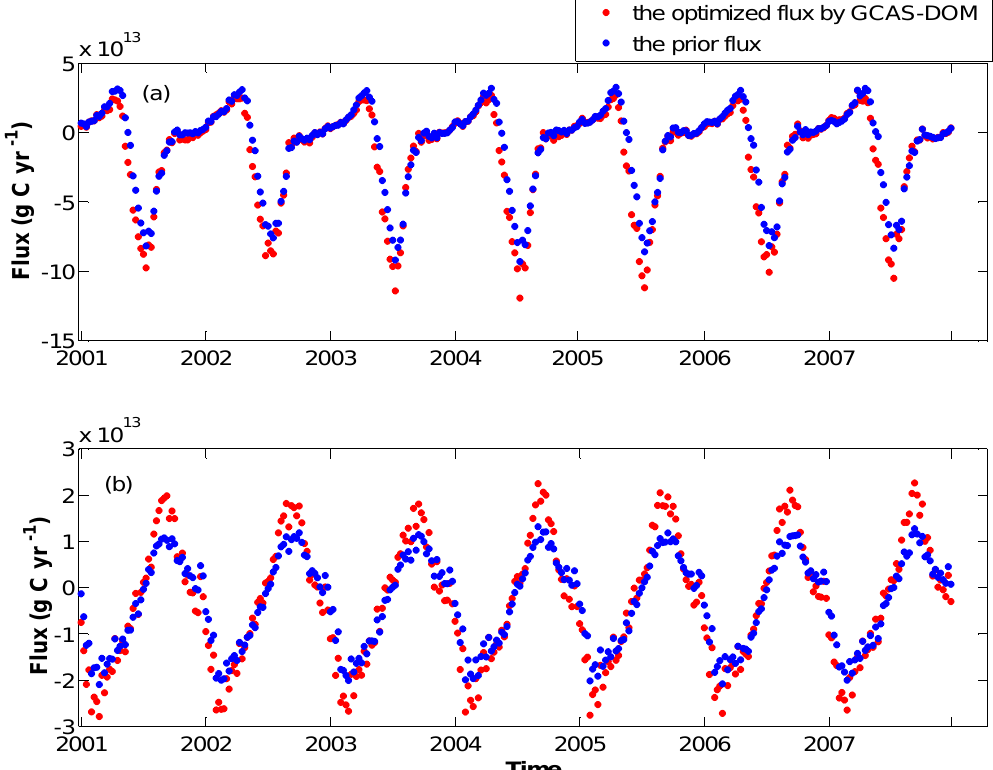
Figure 9. Weekly fluxes for other vegetation. (a) Northern Hemisphere (b) Southern Hemisphere. All units are in gCyr − 1 . Note that different scales are used.